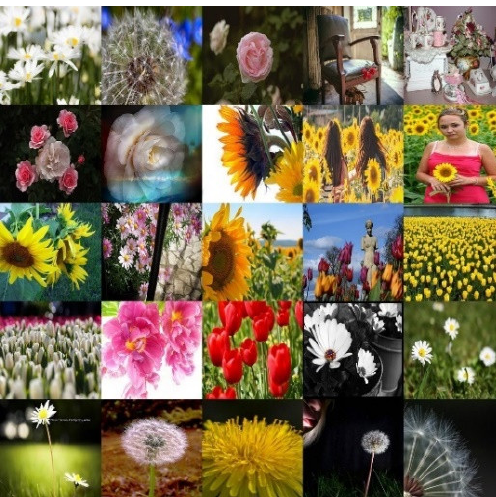
Figure 5. Result of the performance verification experiment on MNIST.